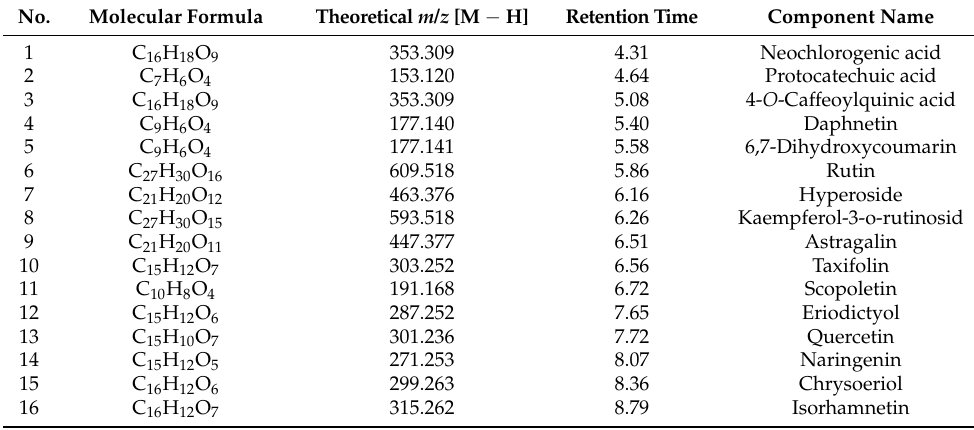
Table 2. Identification of flavonoids in the fruits of Lycium barbarum .